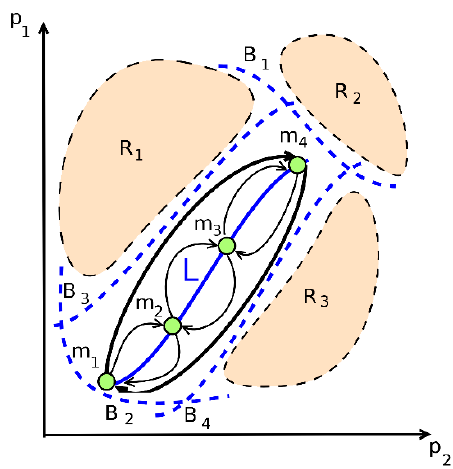
Figure 2. Typical compressor performance map.